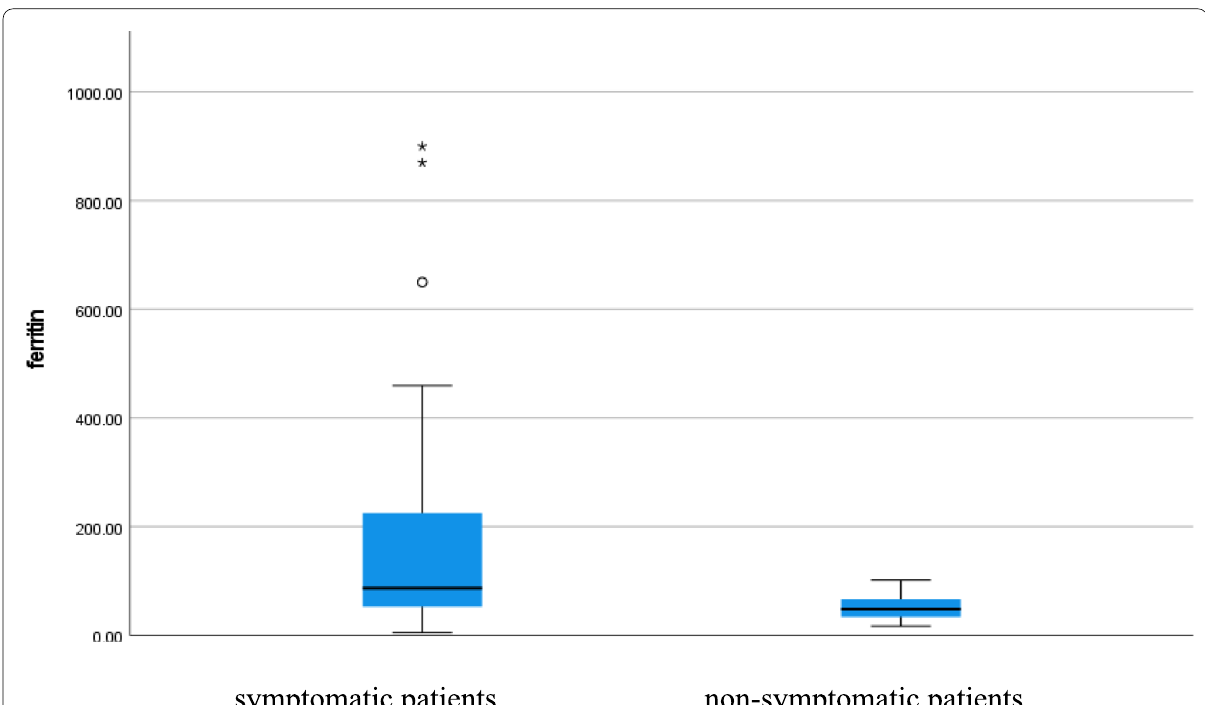
Fig. 5 Serum ferritin level of COVID 19 patients (symptomatic and non-symptomatic)